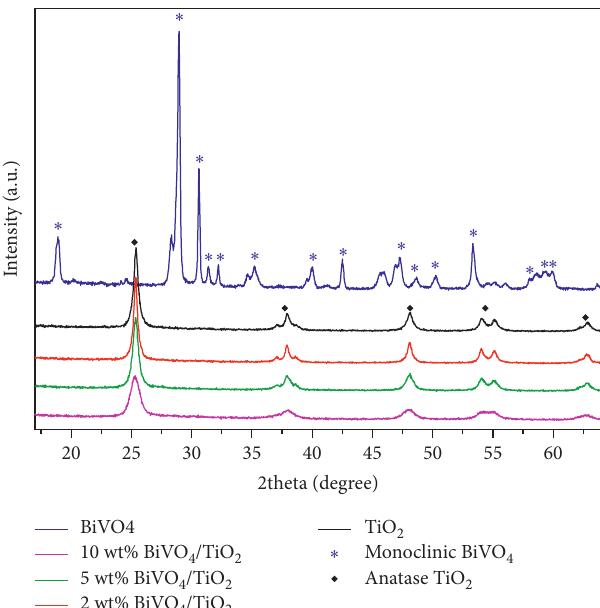
Figure 2: XRD patterns of pure TiO 2 , pure BVO 4 , and BiVO 4 /TiO 2 nanocomposites with different BiVO 4